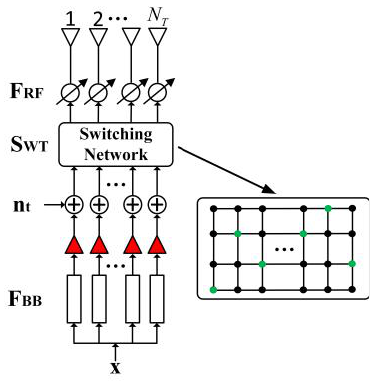
Figure 5. HBF-SN-LASTAR local structure diagram of the transmitter.